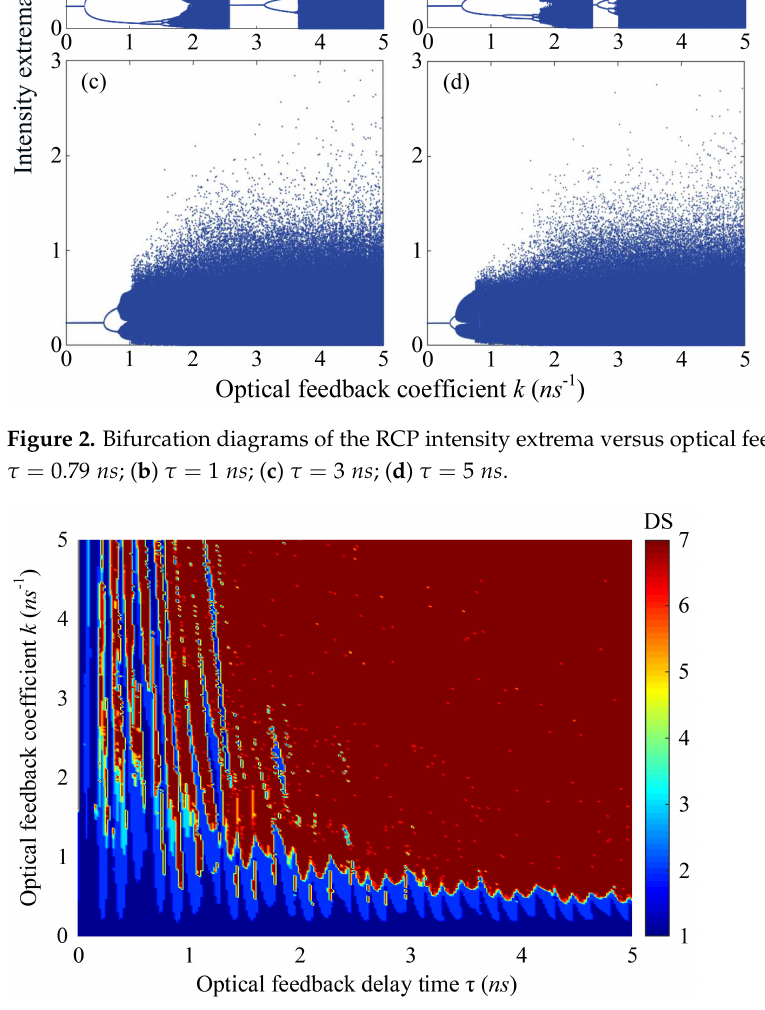
Figure 3. Mapping of the different dynamic states (DSs) of spin-VCSEL with optical feedback in the parameter space of ( τ , k ), in which the other parameters are the same as in the basic set of model parameters. 1: steady state; 2: P1; 3: P2; 4, 5: multi-period; 6, 7: chaos